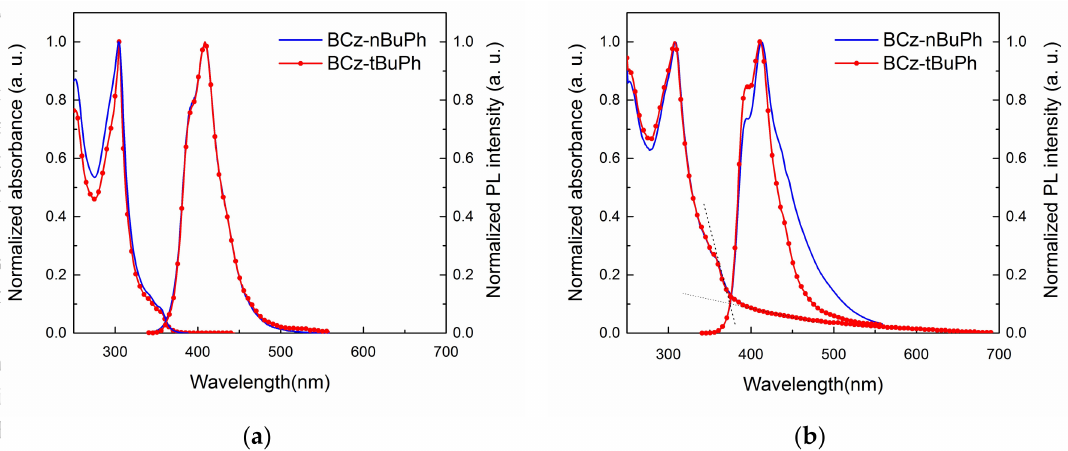
Figure 2. UV-visible absorption and photoluminescence (PL) spectra of BCz-nBuPh and BCz-tBuPh in solution ( a ) and in films ( b